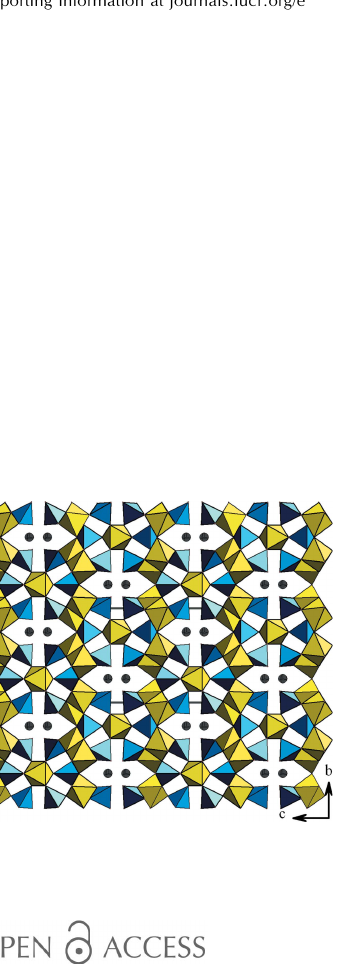
, 2 , (cid:2) y + 1 , (cid:2) z + 1 ; (vi) 2 2 2